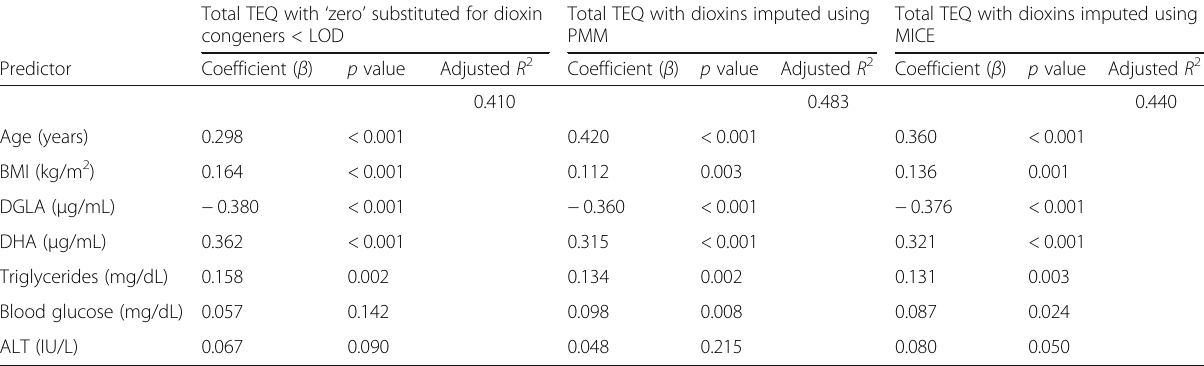
Table 4 Relationship between log-transformed total blood dioxins (in pg TEQ/g lipid) and health parameters/clinical biomarkers, 2011 – 2016 SEDOCCH ( N = 490) Total TEQ with ‘ zero ’ substituted for dioxin congeners < LOD